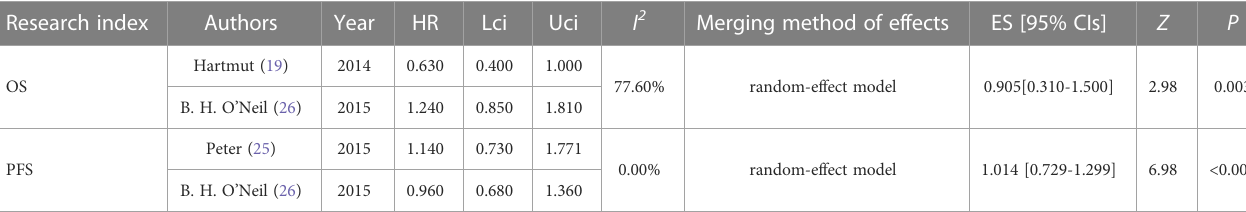
TABLE 2 The pooled ES for OS and PFS by overall population.